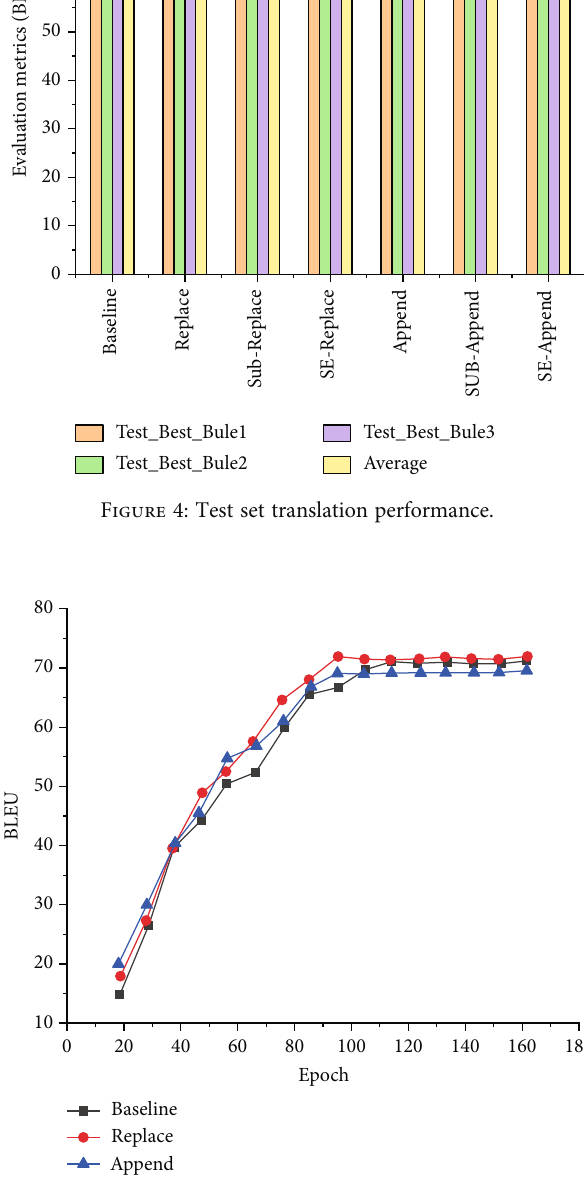
Figure 5: Epoch-BLEU change chart 1.